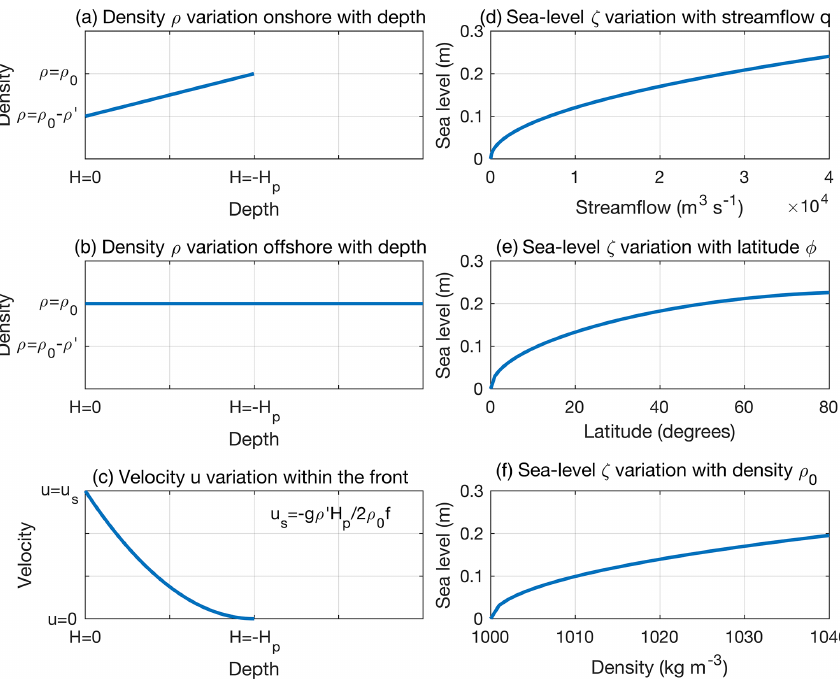
Figure 11. Idealized (a) density structure onshore of the front (Eq. 20), (b) density structure offshore of the front (Eq. 21), and (c) velocity structure within the front (Eq. 21) as a function of depth. Sea-level response ζ described by Eq. (28) as a function of (d) streamflow q , (e) latitude φ , and (f) ambient ocean density ρ 0 . Default values: q = 2 × 10 4 m 3 s − 1 , φ = 35 ◦ , ρ 0 = 1030kgm − 3 .